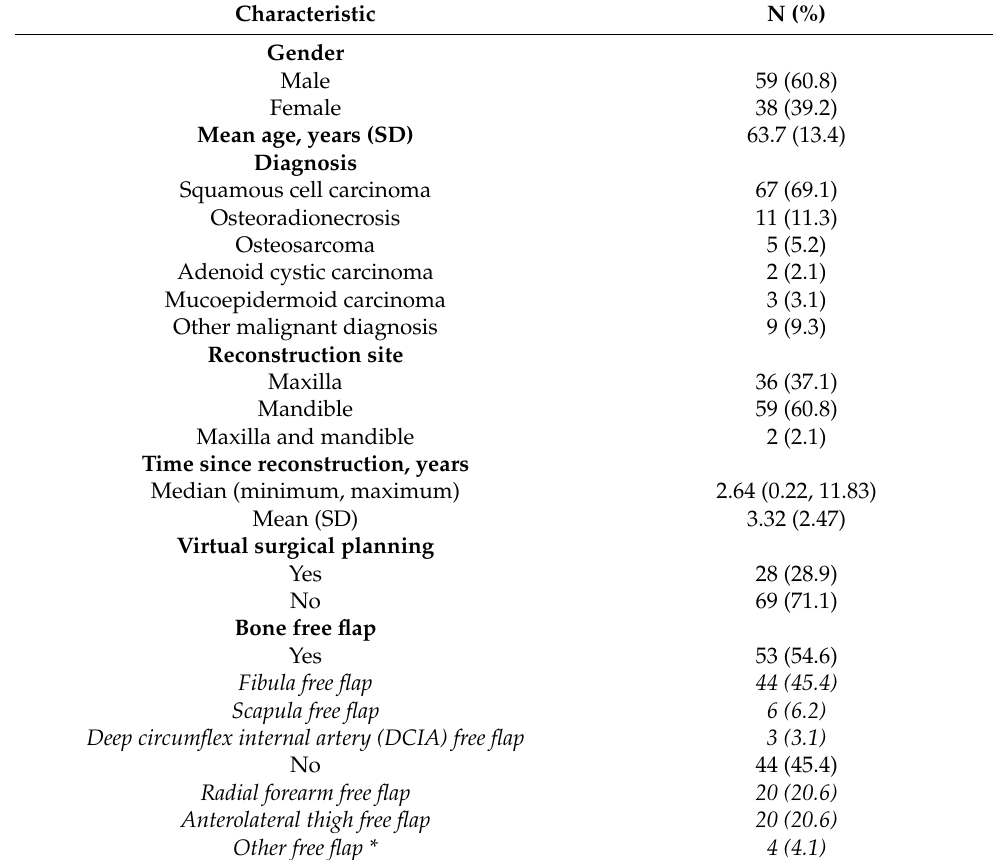
Table 1. Participant